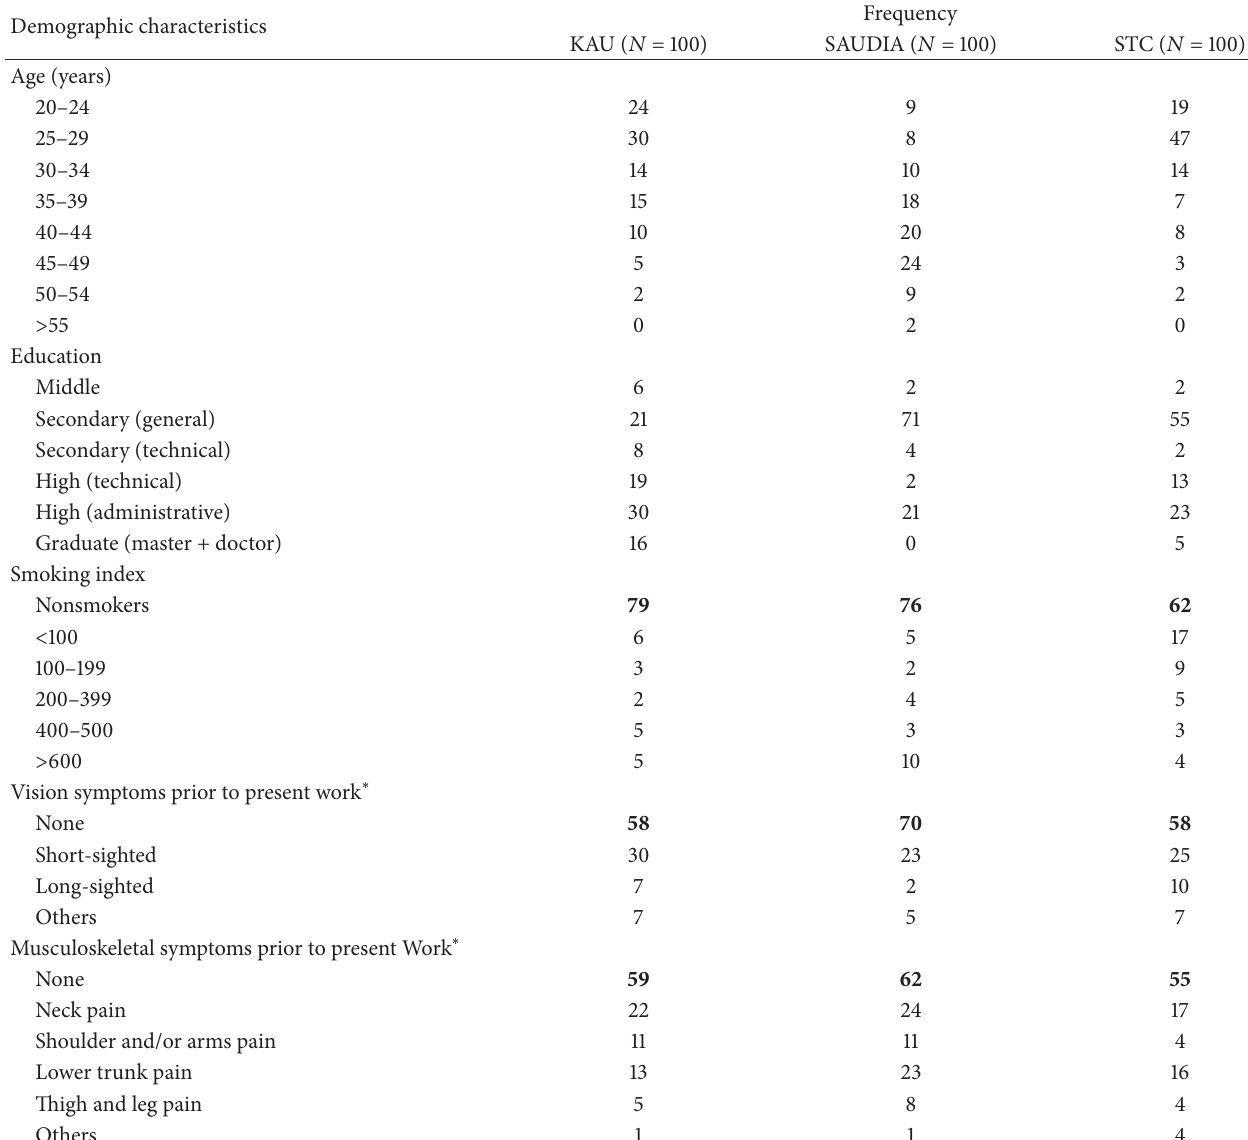
Table 4: Demographic characteristics of the study